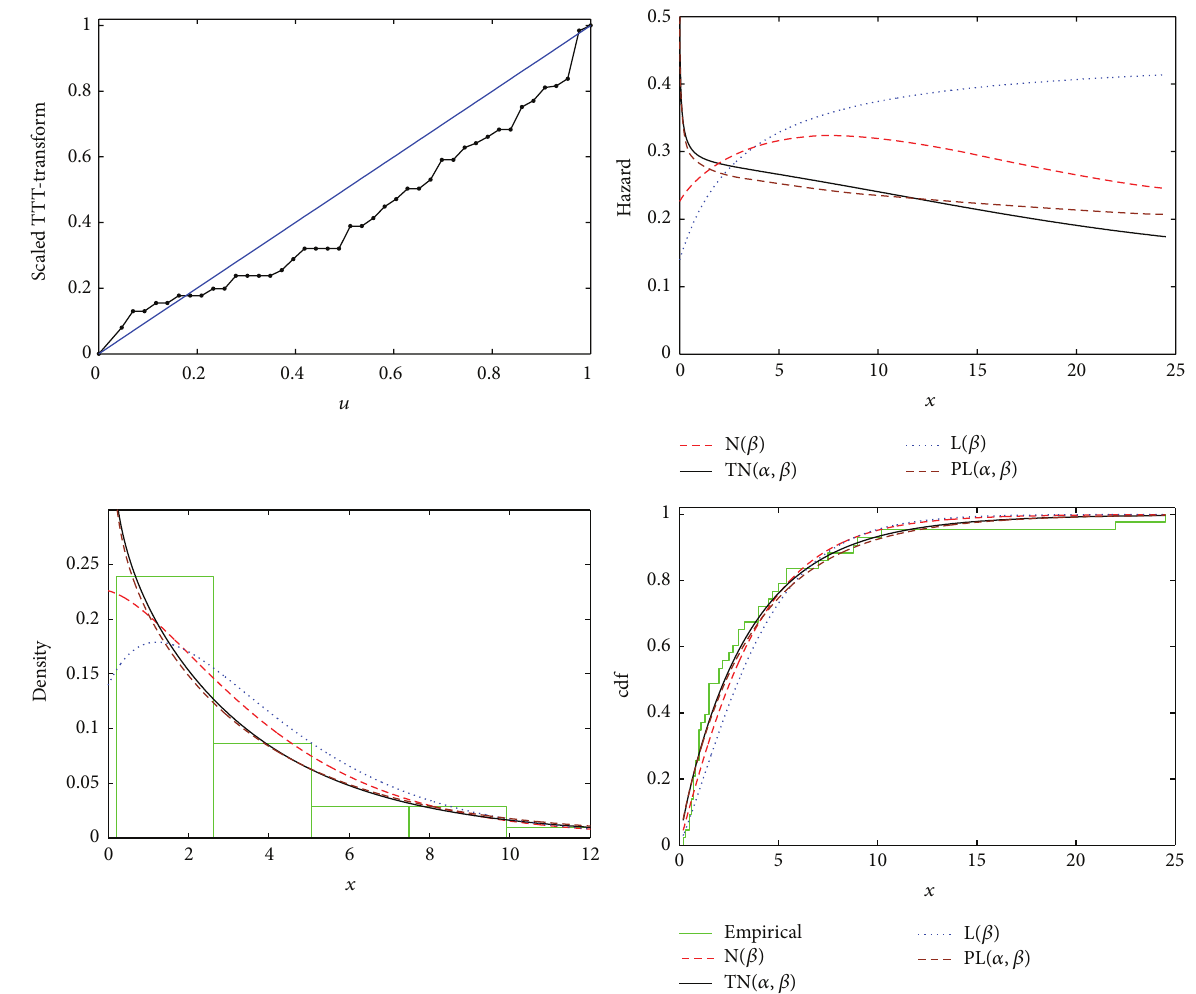
Figure 9: The TTT-transform, hazard, pdf, and cdf of the active repair times data. Table 1: Parameter estimates, maximum log-likelihood, and AIC for the four data